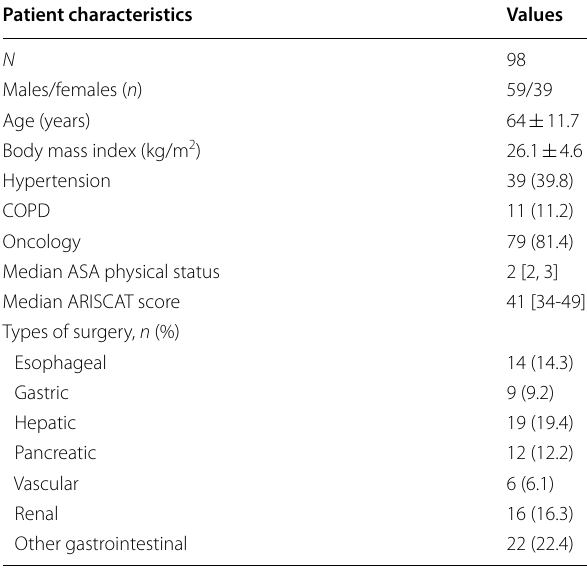
Data represent mean standard deviation, median with [interquartile range] or ± number of cases (percentage) ASA American Society of Anesthesiologists, ARISCAT Assess Respiratory risk In Surgical patients in CATalonia